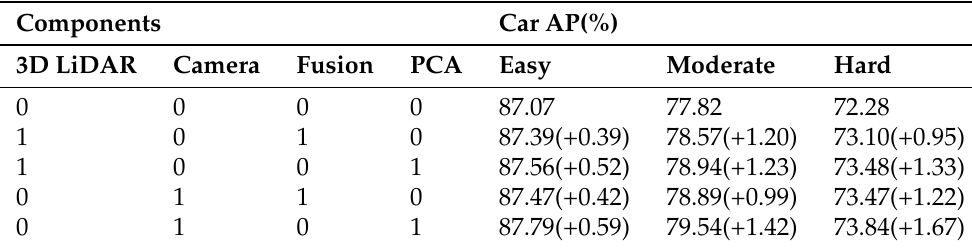
Table 1. The enhanced Three-Dimension detection capabilities offered by several LiDAR signals and feature combination techniques on the KITTI dataset. The accuracy gains are indicated via brackets. Components